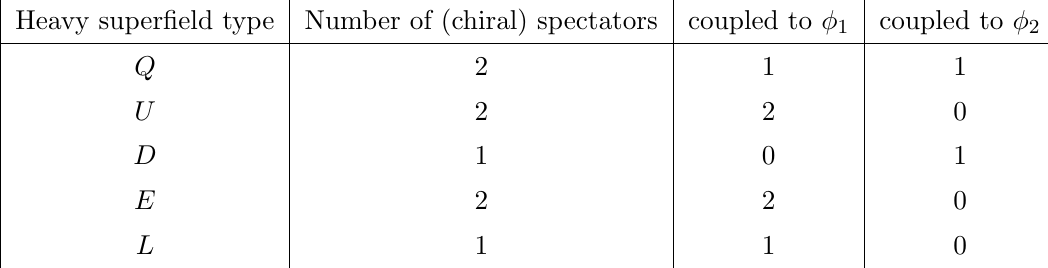
Table 6 . Spectators chiral couplings in the minimal vector-like counterpart to model B. a chiral way to (cid:30) and (cid:30) , distributing the remaining available super(cid:12)elds as in table 1 2